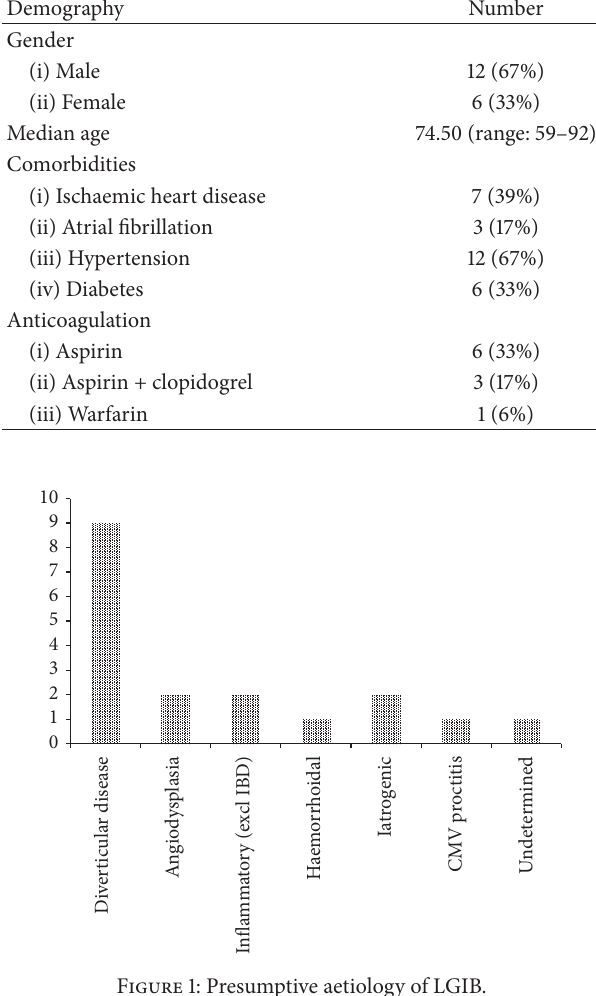
Figure 1: Presumptive aetiology of